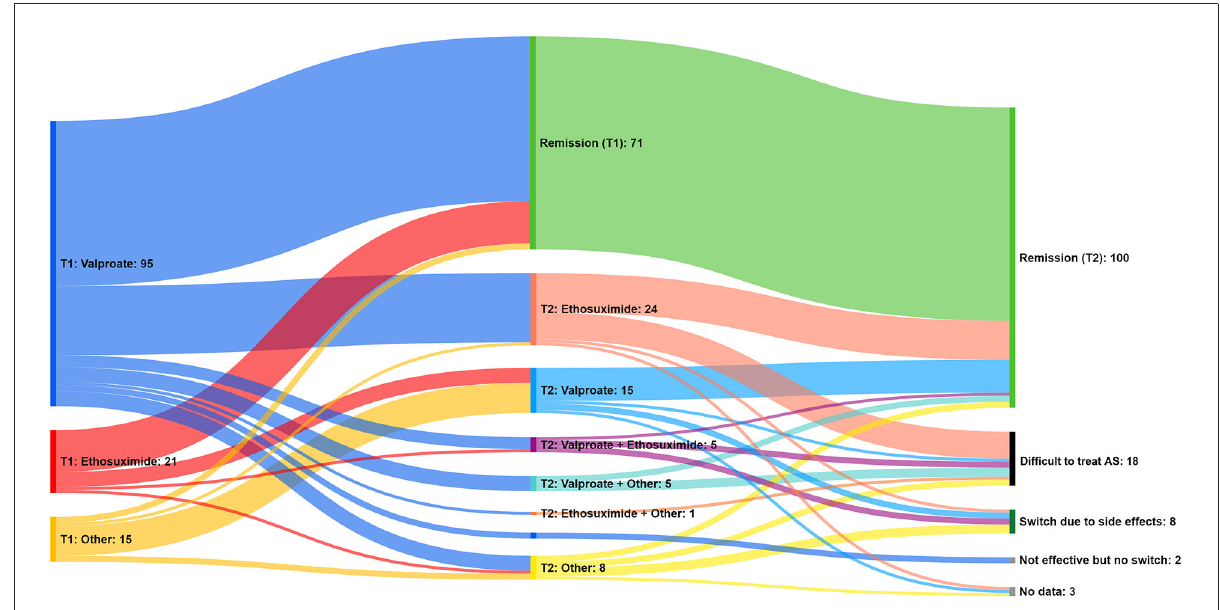
FIGURE1 The flow of patients regarding 1st and 2nd line ASM treatment and the observed outcomes. Only patients who did not switch to next ASM treatment for any reason (such as side effects) were considered to have achieved remission for the purpose of this figure.